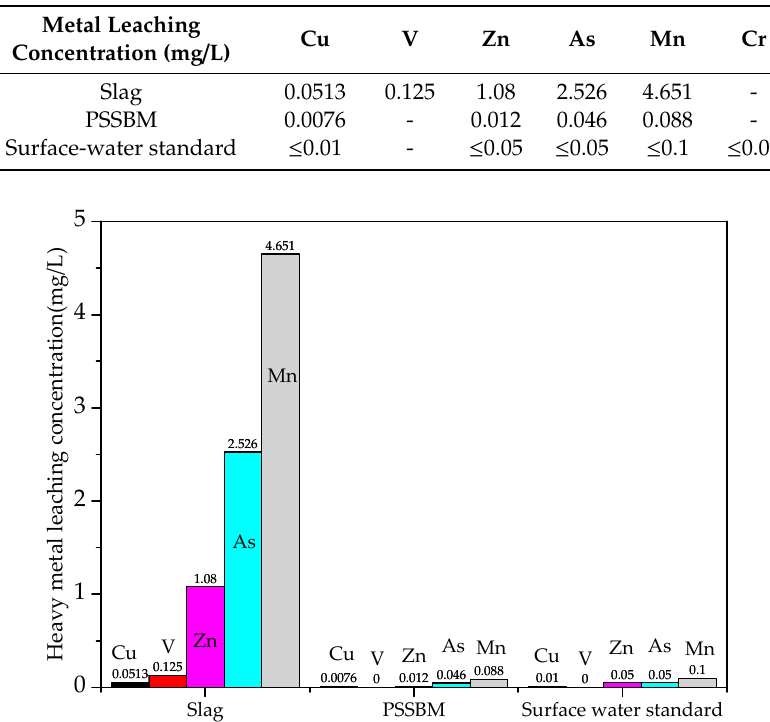
Figure 2. Toxic leaching of steel slag and PSSBM.